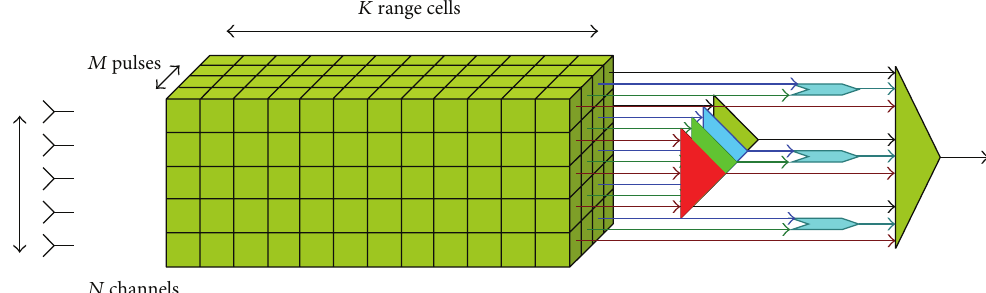
Figure 12: Symmetric auxiliary sensor/echo processor of Klemm [4], as an example for forming space-time